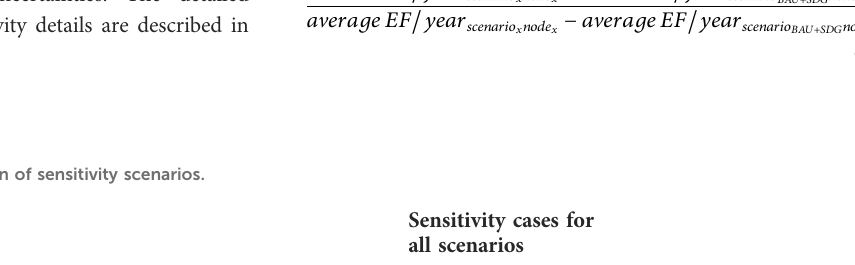
Common assumptions to all